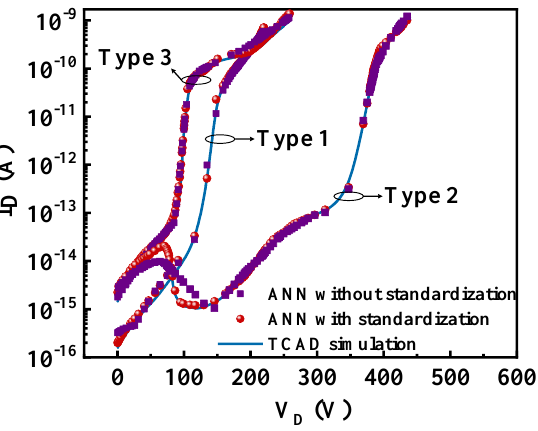
Figure 7. The predicted results consider the conversion function without the standardization factor.